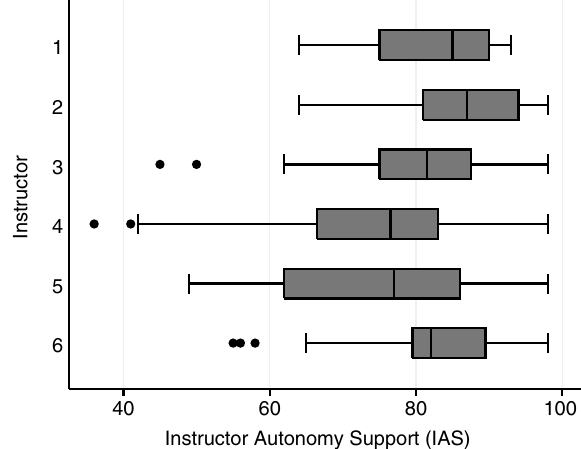
FIG. 1. Box plots for individual instructors comparing the level of instructor autonomy support as perceived by the students in their discussion/lab sections. Instructor 5 is included here for comparison only, and is not included elsewhere in this work. Box plots give the five-number summary: median (vertical line in the box), 25th and 75th percentile (edges of the box), lower and upper adjacent values (i.e, the lowest datum and highest datum within 1.5 interquartile range of the lower and upper quartile, respec- tively; ends of the whiskers), and values outside the adjacent values (dots). We see that instructor 4 has a lower IAS than Instructors 1, 2, 3, and 6, suggesting that student-perceived IAS is measuring an instructor